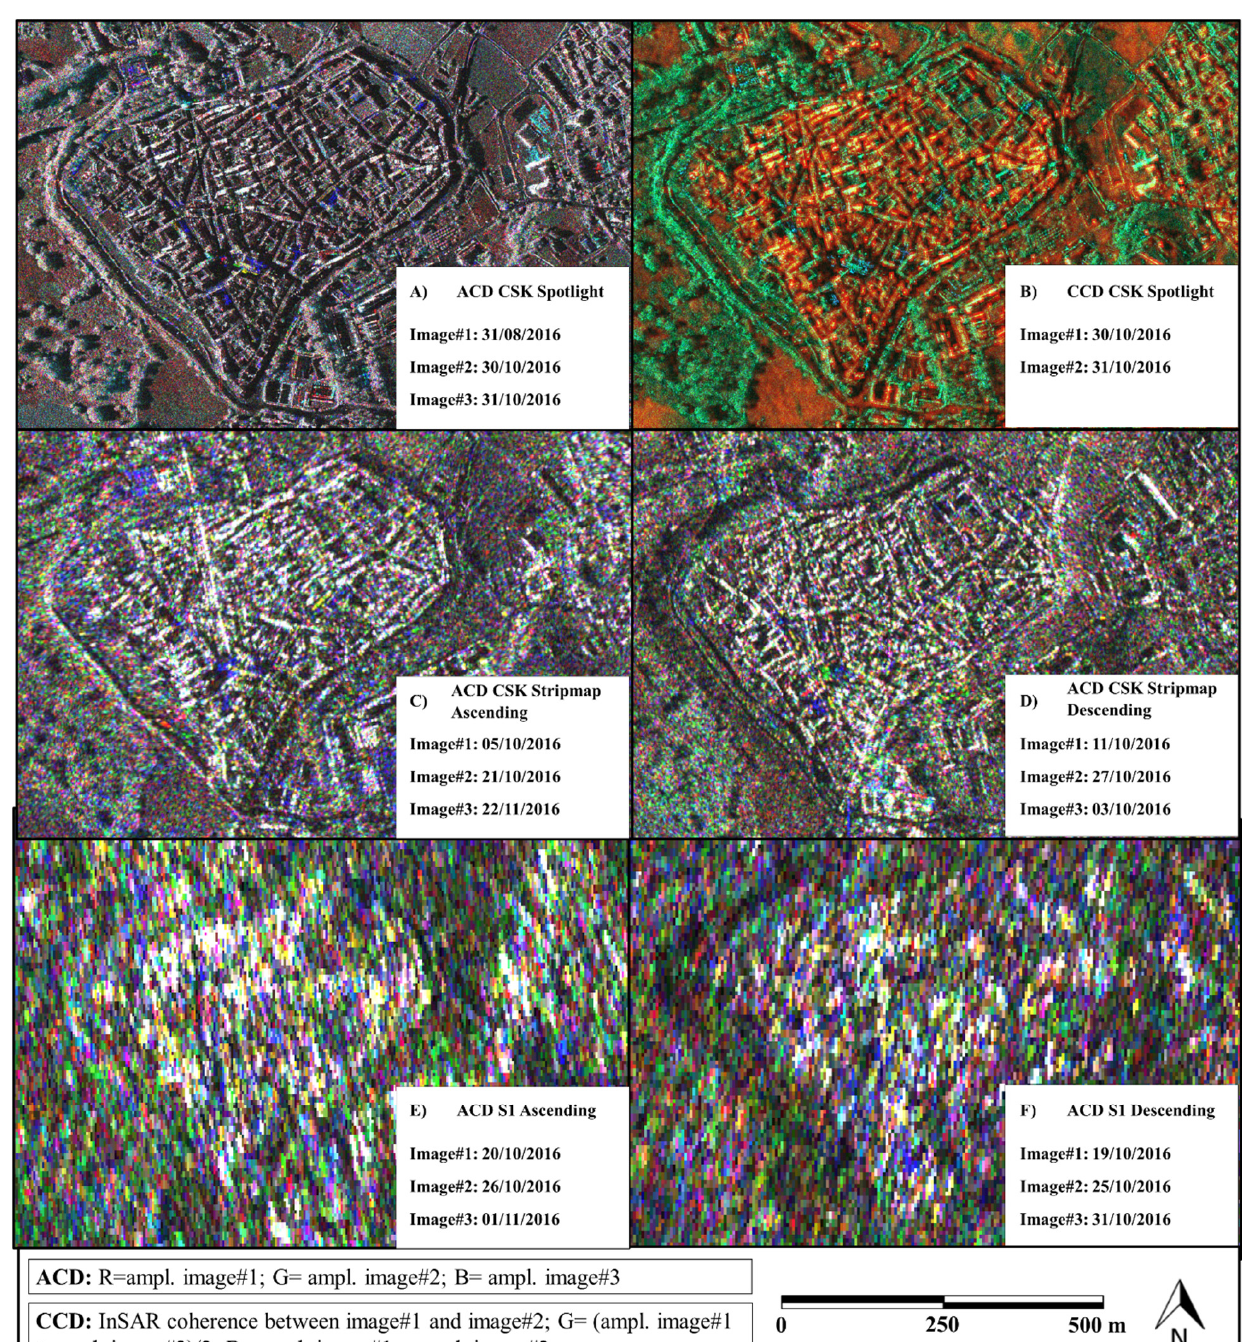
Figure 3. Results achieved in Norcia village: A) ACD Spotlight COSMO-SkyMed; B) CCD Spotlight COSMO-SkyMed; C) ACD StripMap COSMO-SkyMed ascending; D) ACD StripMap COSMO- SkyMed descending; E) ACD IW Sentinel-1 ascending; and F) ACD IW Sentinel-1 descending.